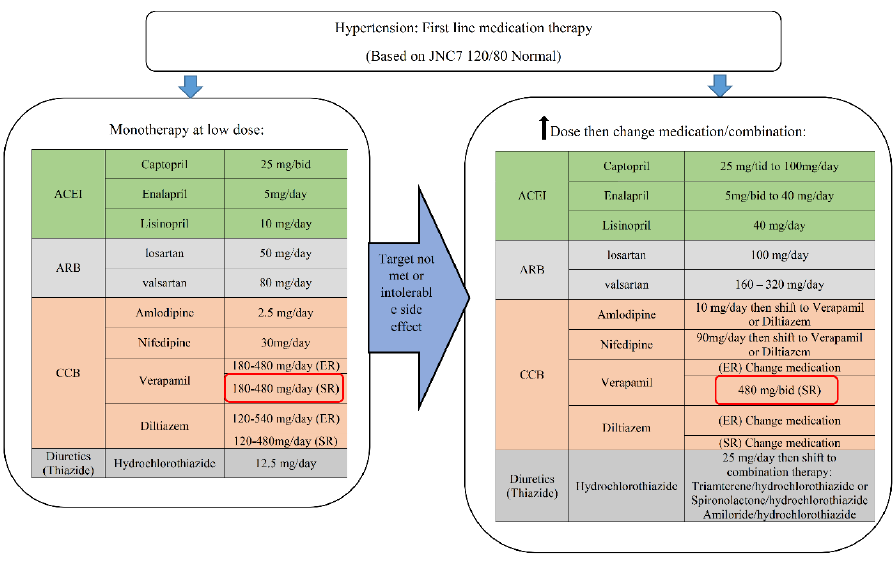
Figure A5. The di ff erent medication therapy scenarios in Figure 2E. The different medication therapy scenarios in hypertension.